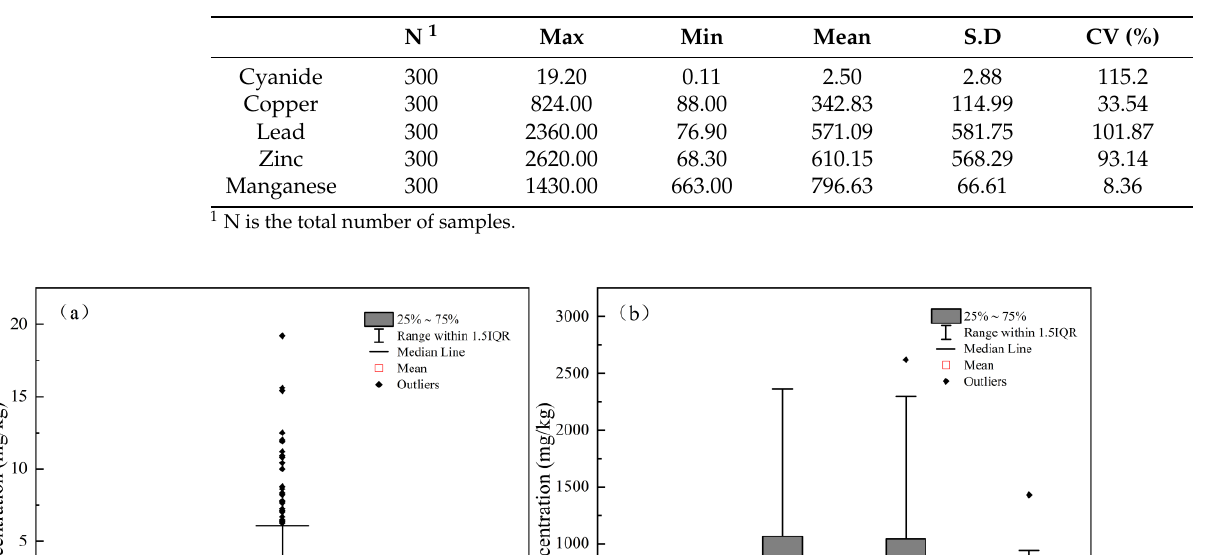
Table 3. Descriptive statistics of cyanide and heavy metal concentration in tailings (mg/kg).